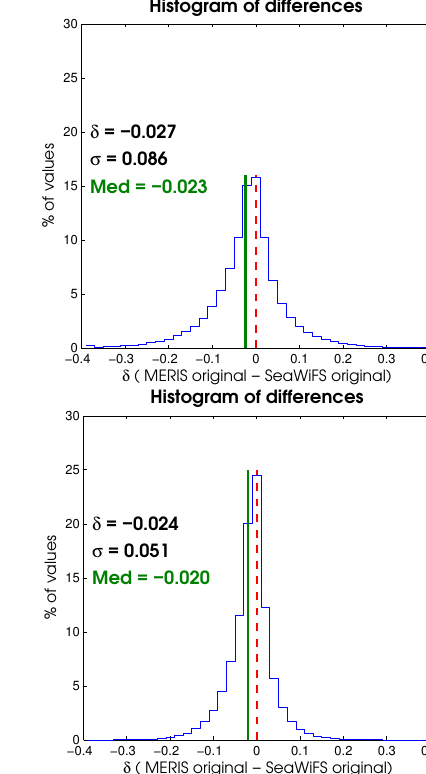
Figure 2. Scatter-plots and histograms of the differences of the FAPAR 10-day product over Europe acquired in 2003 using MERIS and SeaWiFS products over a 1 × 1 pixel ( top ) and 3 × 3 pixel window ( bottom ). Reddish ( bluish ) areas in the plots indicate a higher ( lower ) density of sample points. The 1:1 line is shown in